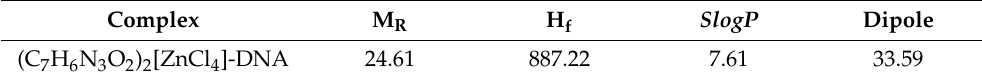
Table 4. Details of steric descriptors calculated from molecular docking information. Complex